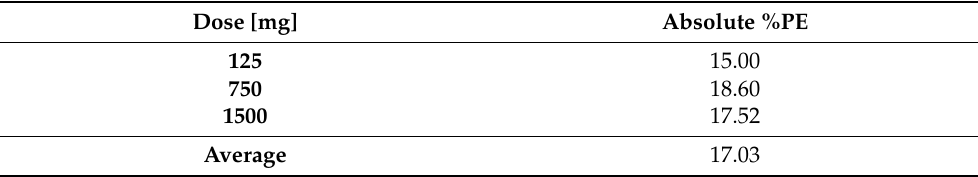
Table A3. Absolute %PEs on C max for IVIVC P-ring model identified on dose 125, 750, and 1500 mg. Dose [mg] Absolute %PE